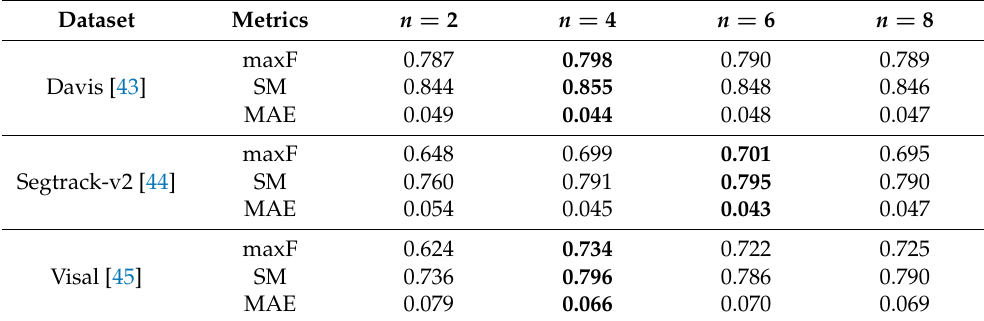
Table 1. Quality of optical flow maps with different perception ranges, the optimal data are represented in bold.